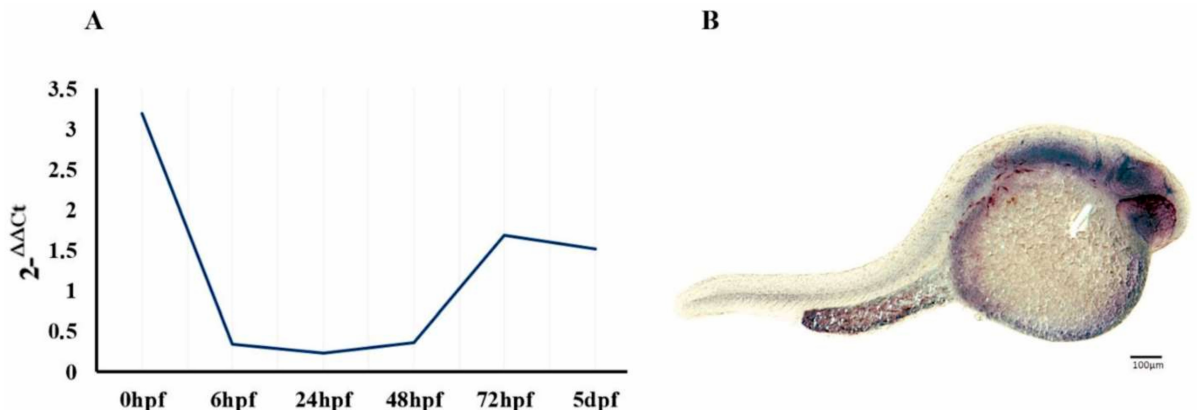
Figure 1. Regional and developmental expression of the epm2a gene. ( A ) qRT − PCR analysis showing epm2a developmental relative expression from 0 hpf to 5 dpf in WT zebrafish. Three independent RNA samples (each obtained from about 30–40 larvae) for each stage. ( B ) Wholemount in situ hybridization showing epm2a regional expression in 24 hpf WT